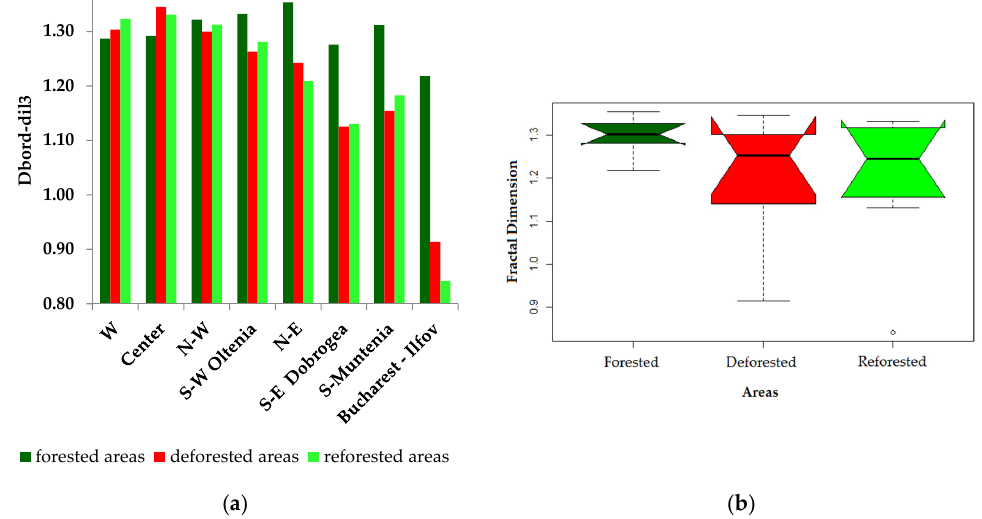
Figure 9. ( a ) D Bord ‐ dil3 of forested, deforested and reforested areas from development regions of Romania; ( b ) Boxplots with notches represent the median, interquartile range and extreme values of D Bord ‐ dil3 of forested, deforested and reforested areas from DRs of Romania.